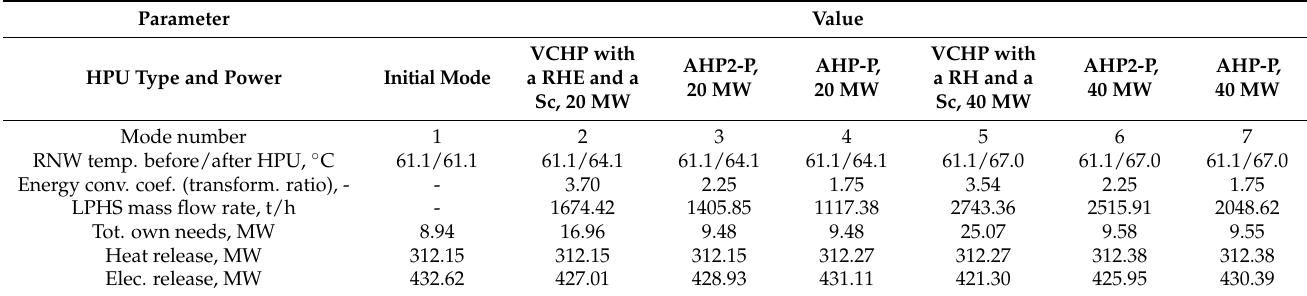
Table 6. The results of using HPUs of various types for heating RNW in the winter mode with low heating loads. Parameter